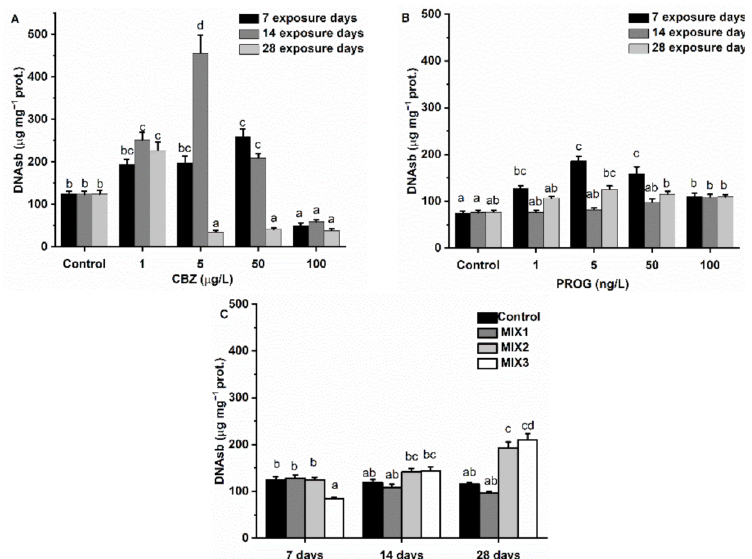
Figure 8. Changes in DNAsb concentration in the liver of Danio rerio exposed to ( A ) CBZ, ( B ) P4, and ( C ) binary mixtures of CBZ and P4 for 7, 14, and 28 days. Data are expressed as mean ± standard deviation of fifteen replicates ( n = 15). Different letters show differences at p < 0.05 after a two-way ANOVA followed by Tukey’s post hoc